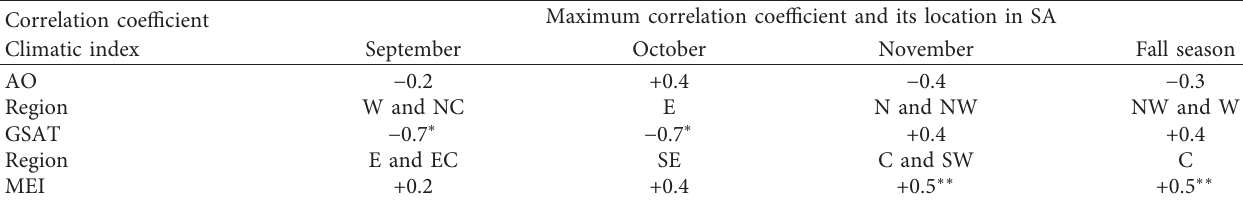
Figure 6: The distribution of the correlation coefficients between the PR over the Arabian Peninsula, including SA, and the climatic indices for September during the study period (1948–2018). (a) AO. (b) GSAT. (c) MEI. (d) NAO. (e) Nino 3.4. (f) SOI (NCEP/NCAR Reanalysis NOAA/ESRL Physical Sciences Table 1: The matrix of correlation coefficients between the PR over SA and the chosen climatic indices for specific locations over SA during the fall seasons of the study period (1948–2018).